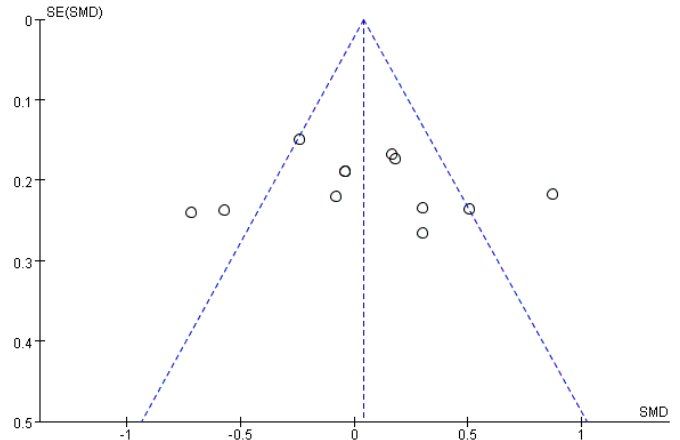
Figure 5. Forest plot of Neuropsychiatric Questionnaire scale for neuropsychiatric function improvement [32,36].